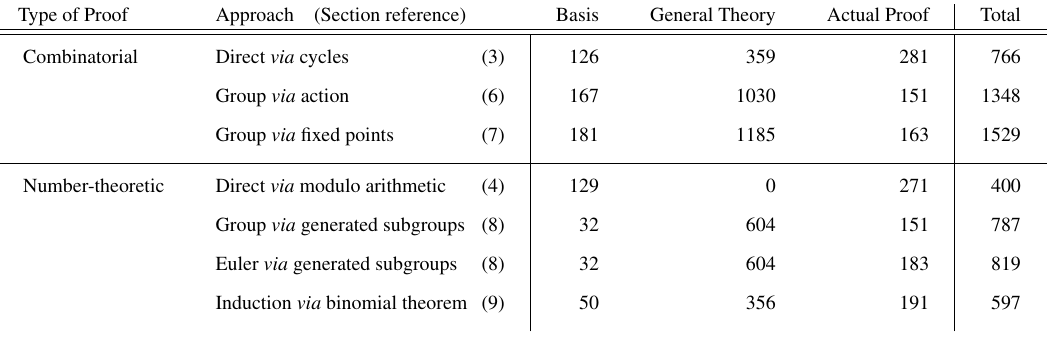
Table II. Each linearized proof script consists of 3 sections: basis, general theory and actual proof. Individual line counts of each section, making up the total, are